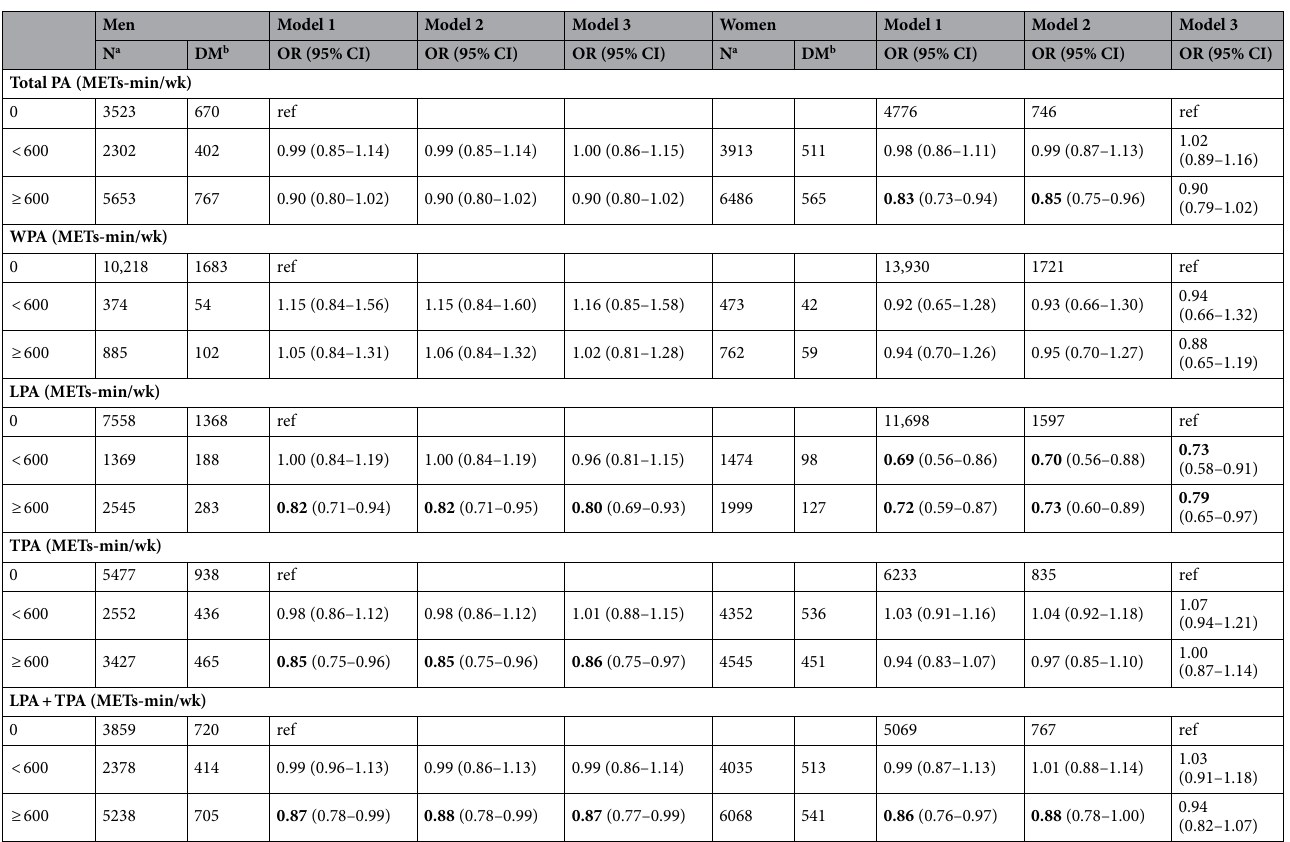
Table 2. Odds ratio (95% CI) of diabetes according to domain-specific physical activity. Model 1: Adjusted for age, Model 2: Adjusted for Model1 + DM family history, alcohol consumption, smoking, income, education, menopause, sedentary time, Model 3: Adjusted for Model 2 + BMI, Bold is p < 0.05, Abbreviation: DM, diabetes mellitus; PA, physical activity; WPA, work physical activity; LPA, leisure-time physical activity; TPA, transport physical activity; ref, reference. a Number of participants in each category. b Number of diabetes cases in each